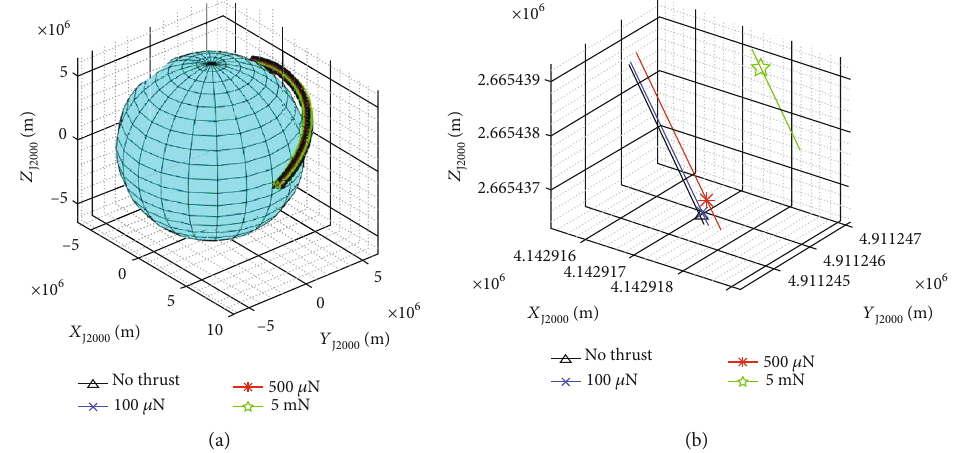
Figure 10: Three-dimensional position and partial enlargement of the satellite orbit under di ff erent thrusts.